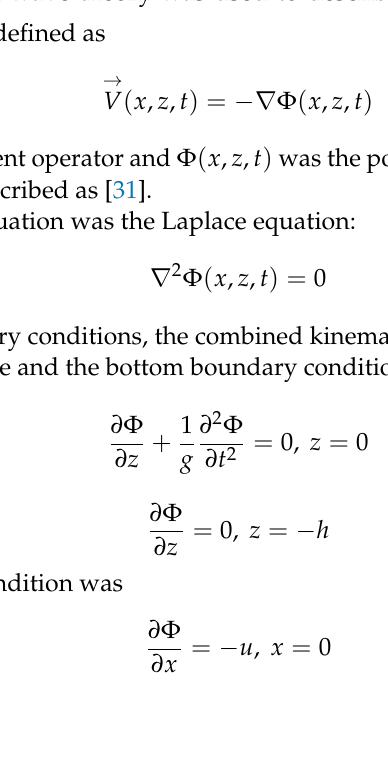
Figure 1. Definition sketch of an inflow channel.